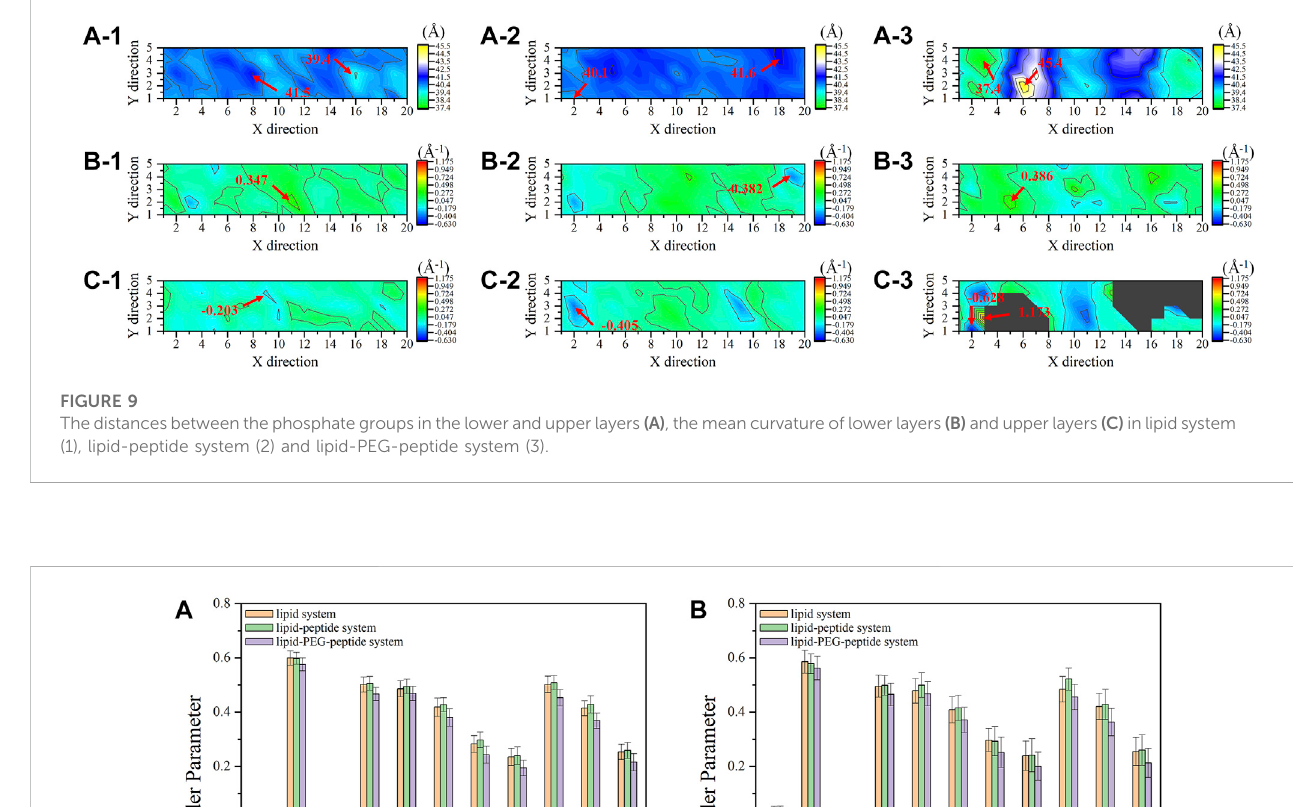
Frontiers in Bioengineering and